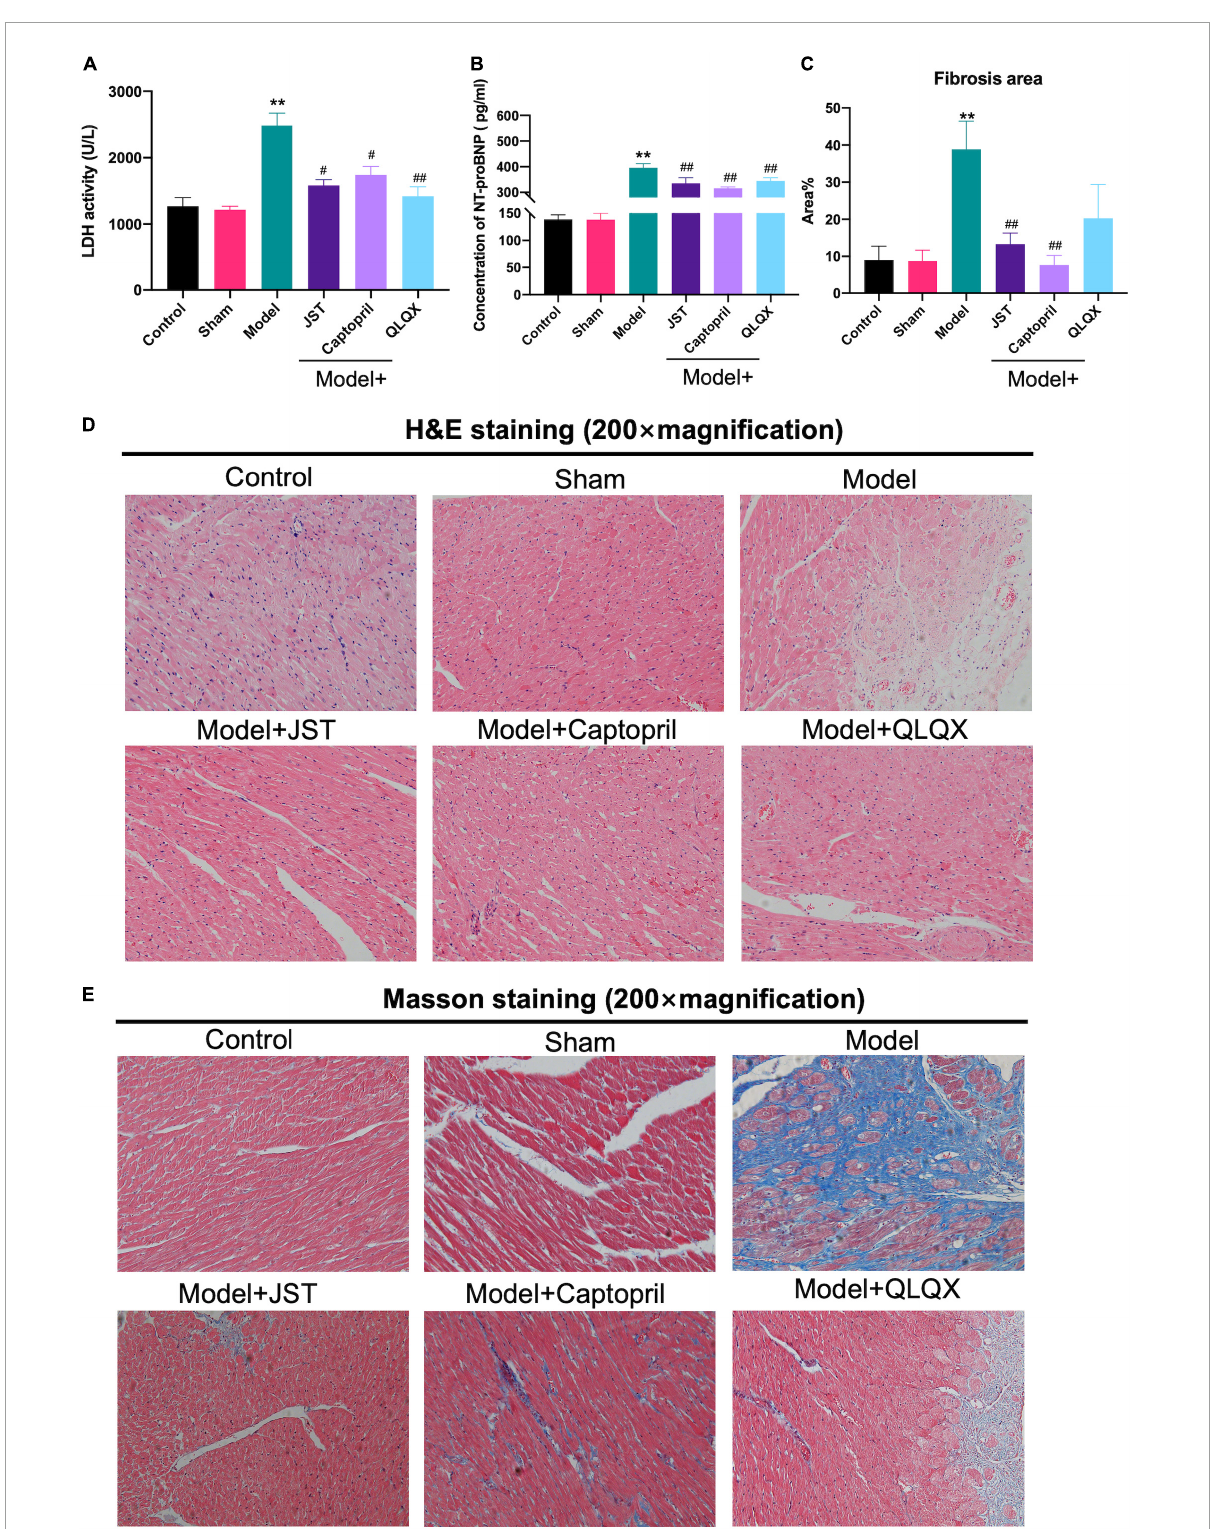
FIGURE3 Effects of JST on serum cardiac enzymes and histopathological changes in heart failure rats. Serum LDH activity (A) . Serum concentration of NT-pro BNP (B) . Quantitative assessment of fibrosis area (%) in Masson’s trichrome-stained heart sections (C) . Representative heart sections stained with H&E (D) and Masson’s trichrome (E) . All data were expressed as mean ± SD ( n = 4–6). ** P < 0.01, vs. Sham group; # P < 0.05, ## P < 0.01, vs. Model